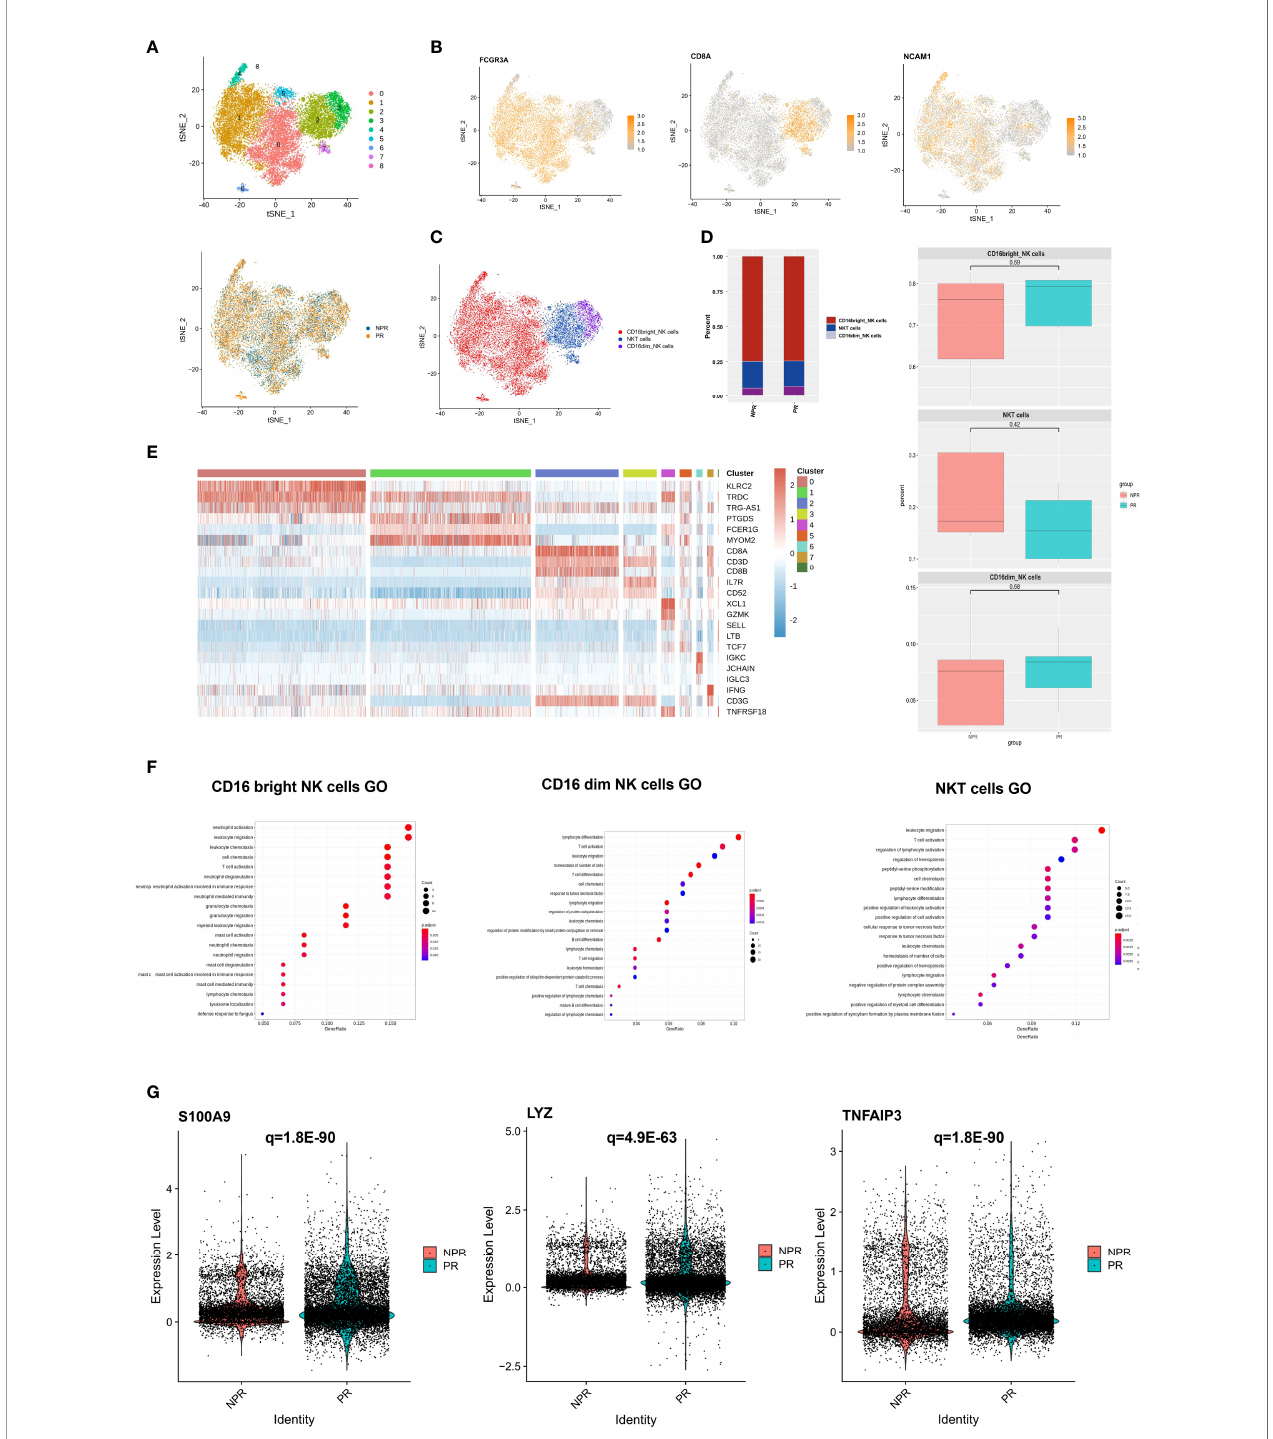
FIGURE 6 | Characterization of NK cells in patients with and without plaque rupture. (A) t-SNE plot showing the re-clustering of NK cells into 9 clusters and t-SNE plot of patients with PR and NPR. (B) Expression t-SNE plot of NK cell marker genes as FCGR3A, CD8A, and NCAM1. (C) t-SNE plot showing the contribution of different NK cell subsets. (D) Percentage of NK cell subtypes in patients with PE and PR. (E) Heatmap showing expression levels of discriminative genes for each cluster. (F) GO analysis of upregulated genes in CD16 bright NK, CD16 dim NK, and NKT cells. (G) Expression of pro-in fl ammatory hub genes such as S100A9, LYZ, and TNFAIP3 were signi fi cantly upregulated in CD16 bright NK cells of patients with